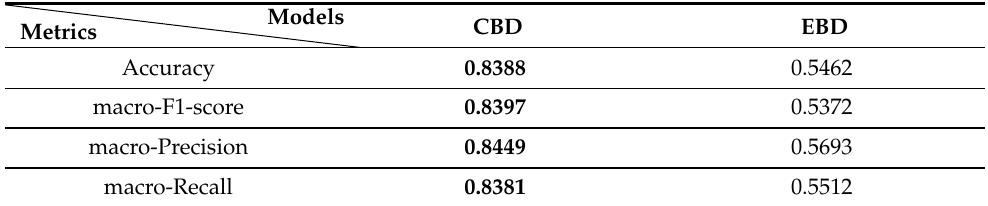
Table 4. Evaluation metrics of CBD model and EBD model when BERT layers = 8, sample size = 0.4, and pre-training epoch =